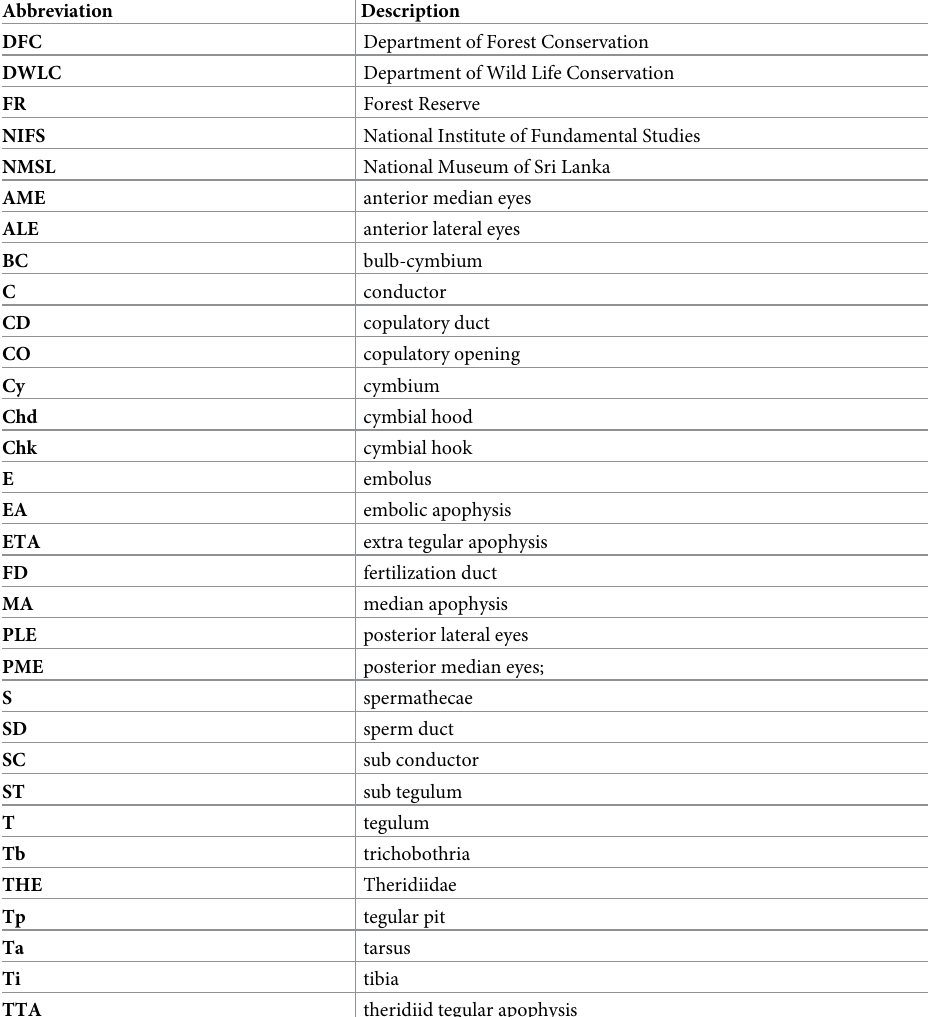
Table 4. Table of abbreviations used in the